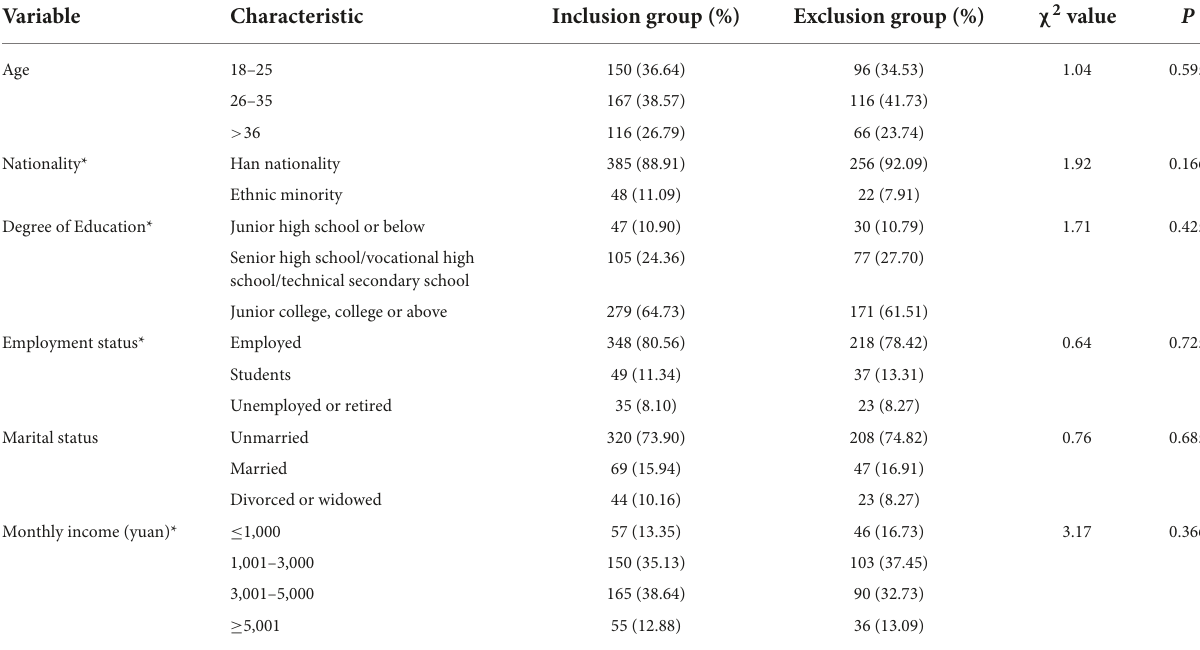
TABLE 1 Comparisons of demographic characteristics between the inclusion group and the exclusion group among men who have sex with men (MSM).